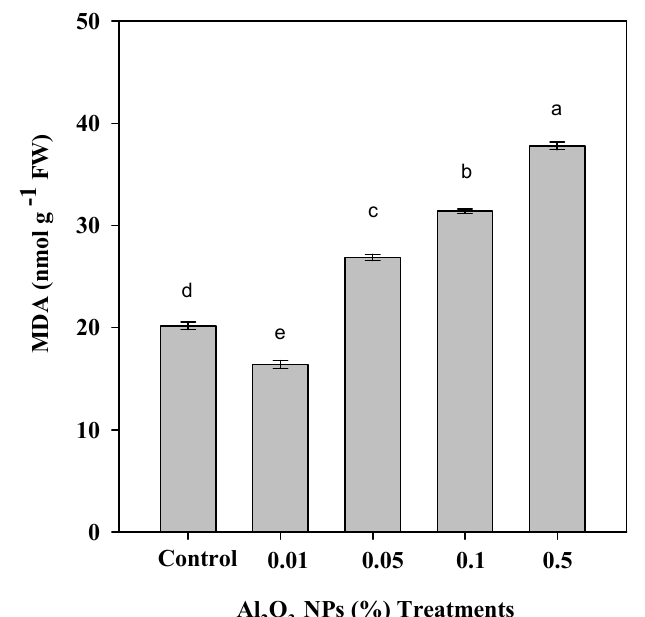
Figure 5. Effects of seed-priming with aluminum nanoparticles (Al 2 O 3 NPs) on malondialdehyde content (MDA) in roselle plants. Bars represent standard deviation (±SD) of the means ( n = 3). Different letters indicate significant differences among the treatments at p ˂ 0.05, according to Duncan’s multiple range test.